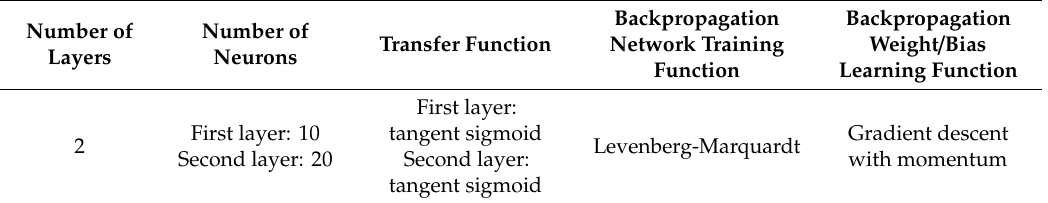
Table 4. Optimal values of ANN parameters determined by imperialist competitive algorithm (ICA).